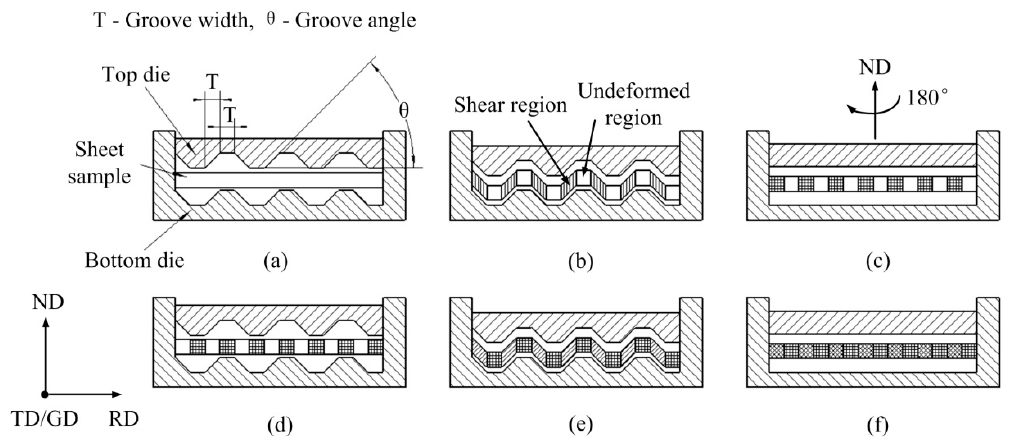
Figure 1. Schematic of the constrained groove pressing (CGP) process: ( a ) Preparation; ( b ) press 1; ( c ) flat 1; ( d ) sample rotation; (e) press 2; ( f ) flat 2. Reproduced from [5], with permission from Elsevier, 2019.